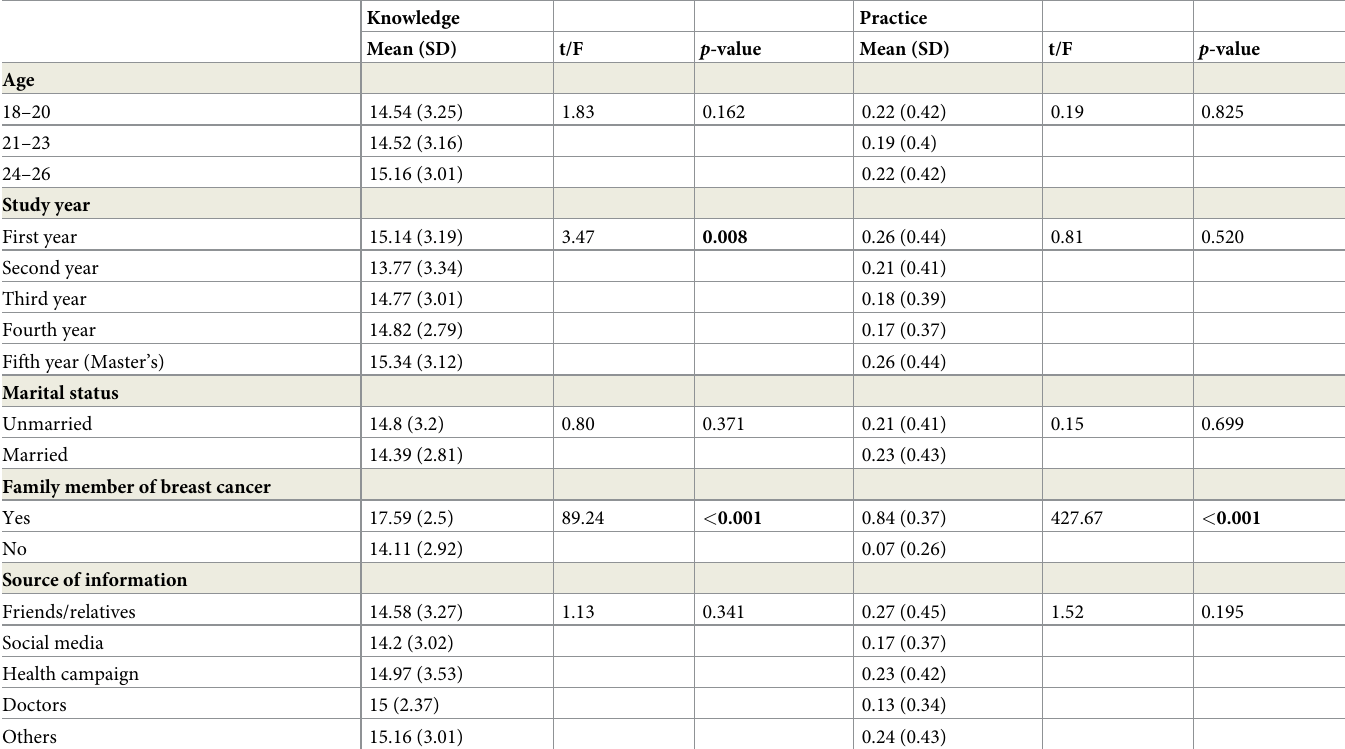
Table 3. Participants’ total knowledge and practice.